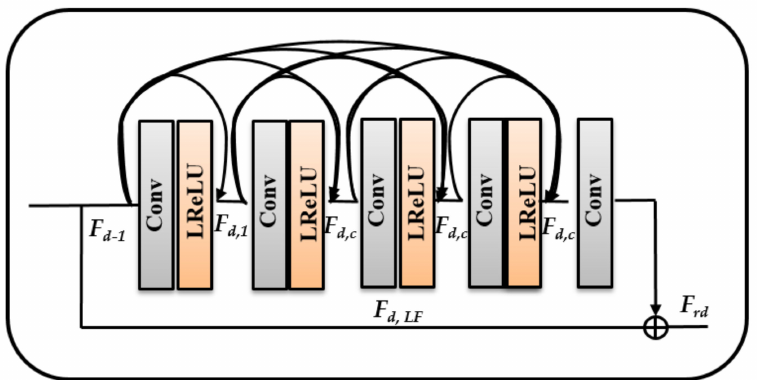
Figure 2. Inner layers and dense connections of RDB .